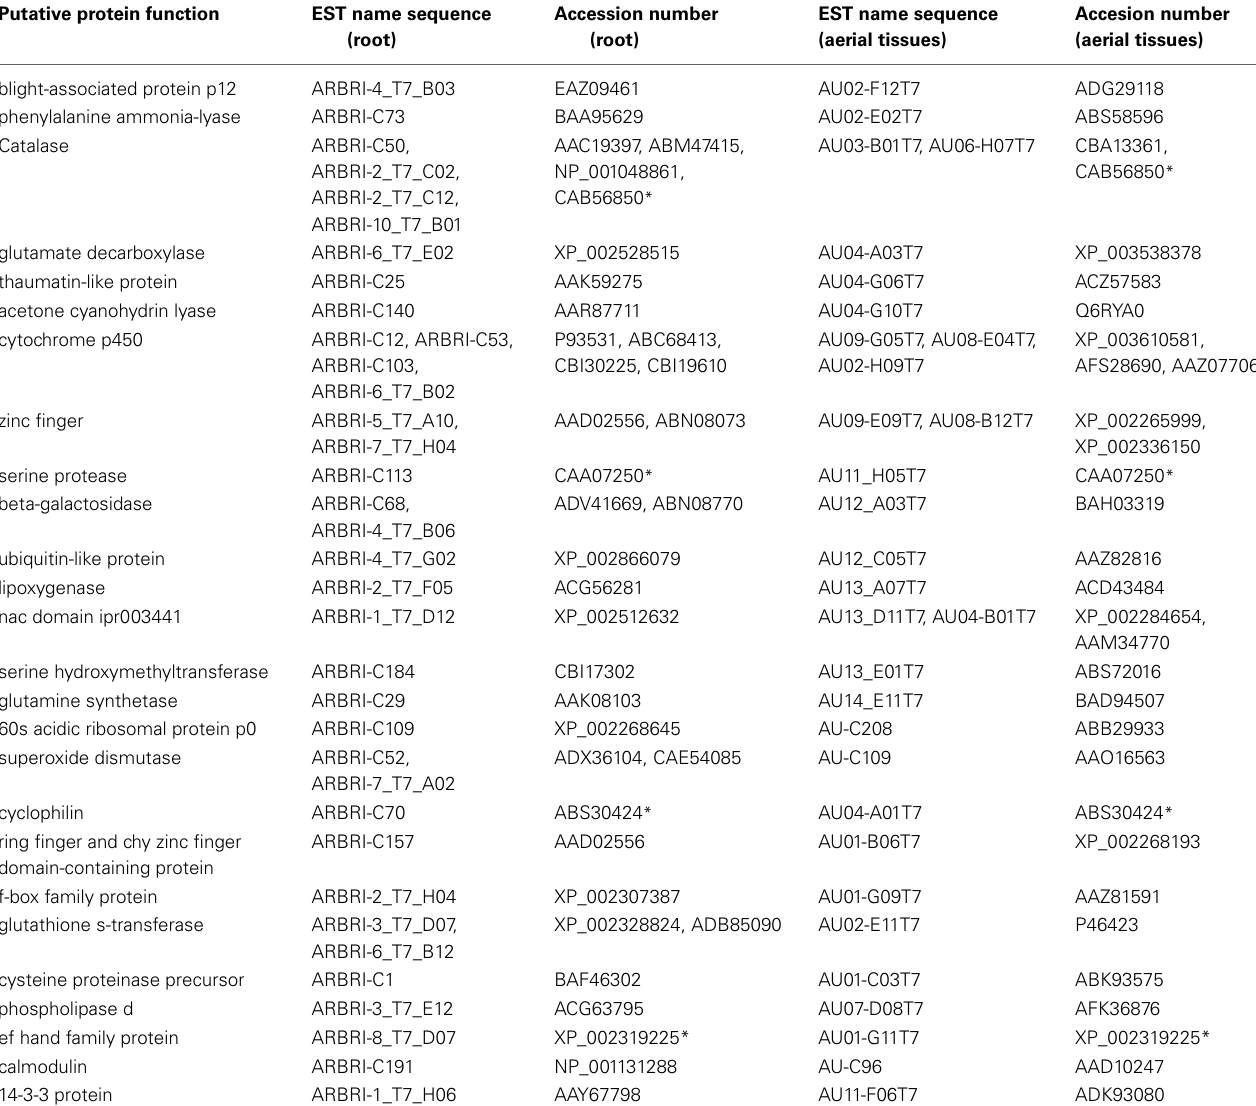
Table 3 | Putative protein functions identified in Pseudomonas fluorescens PICF7-induced EST sequences in both roots and aerial tissues of olive ( Olea europaea